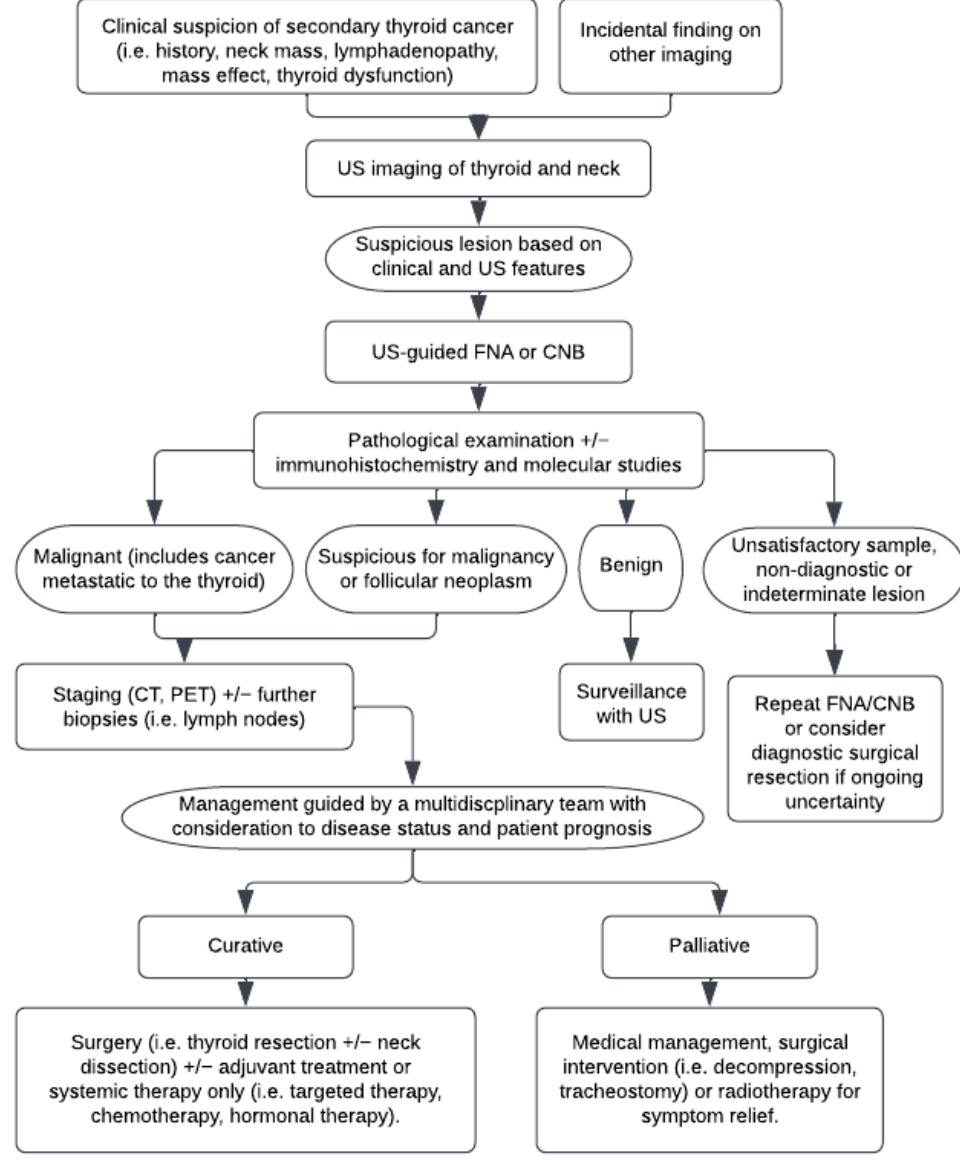
Figure 2. An overview of the assessment and management of potential metastasis to the thyroid. US, ultrasound; FNA, fine-needle aspiration; CNB, core-needle biopsy; CT, computed tomography; PET, fluorodeoxyglucose-positron-emission tomography.